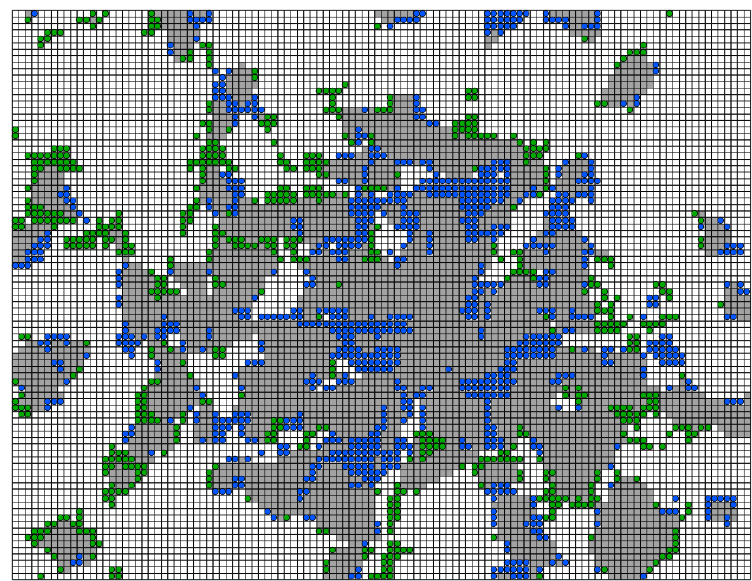
Figure 4. Errors of binomial classification on München (sampling with SCi.SCl and five predictors). Dark gray represents residential areas. Blue dots are the cells erroneously classified as residential. Green dots are cells erroneously classified as